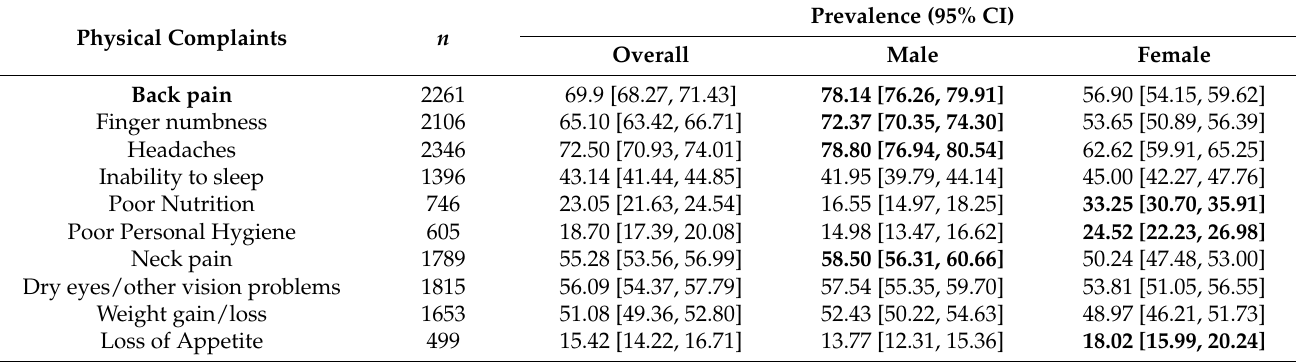
Table 2. Gender differences in the prevalence of self-reported physical health scores among internet users in Bangladesh. Significant variables between males and females are bolded because the confidence intervals did not